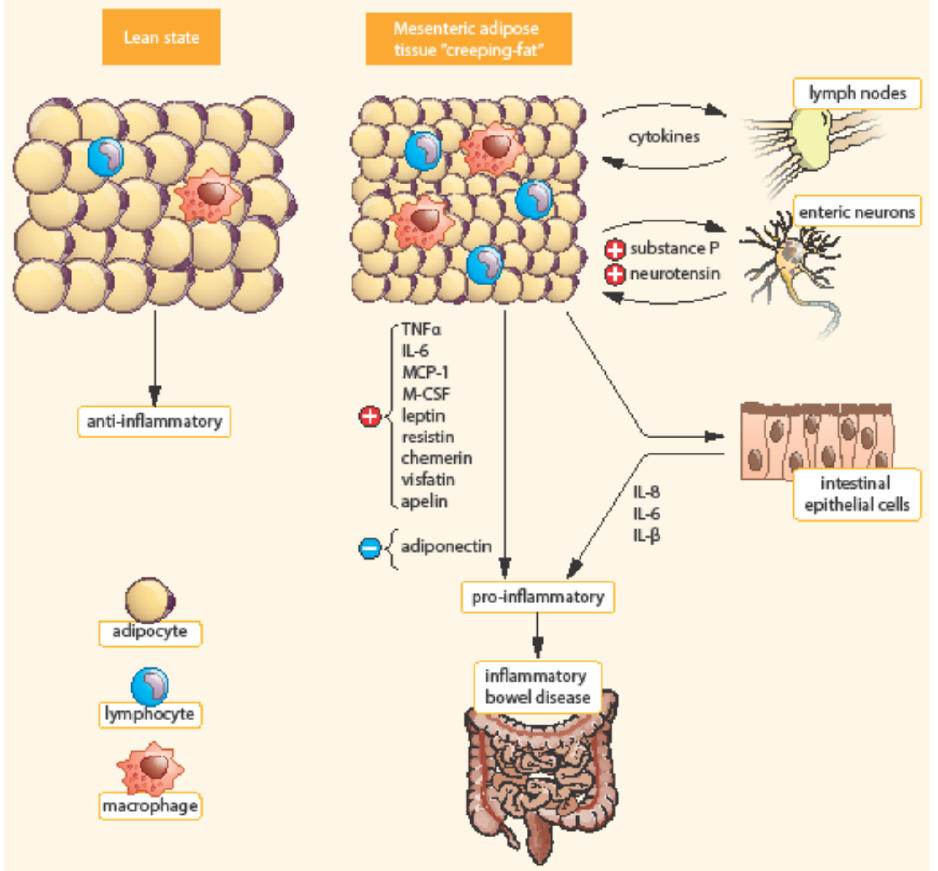
Figure 2. Differences between mesenteric adipose tissue in healthy individuals and patients with IBD. Adapted from [3]. In contrast to lean state, creeping fat is characterized by smaller, highly active adipocytes, with enhanced expression of pro-inflammatory mediators (TNF- α , IL-6, etc.). Mesenteric adipose tissue is infiltrated by immune cells (macrophages, lymphocytes) with enhanced production of chemokines (MCP-1, M-CSF). In addition, pre-adipocytes can differentiate into macrophages. TNF- α , Tumor necrosis factor α ; IL, Interleukin; MCP-1, Monocyte chemotactic protein-1; M-CSF, Macrophage colony-stimulating